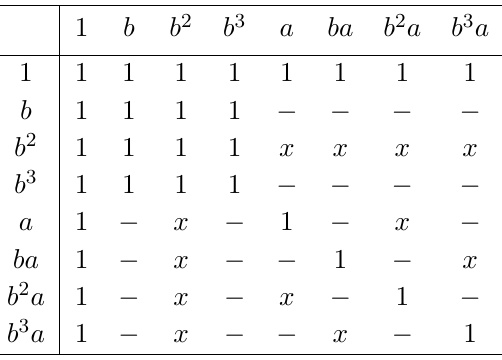
Table 3 . Table of cocycles representing elements of H 2 ( D 4 , Z 2 ) = ( Z 2 ) 3 . The variables x , y , z generate the three Z ’s. 2